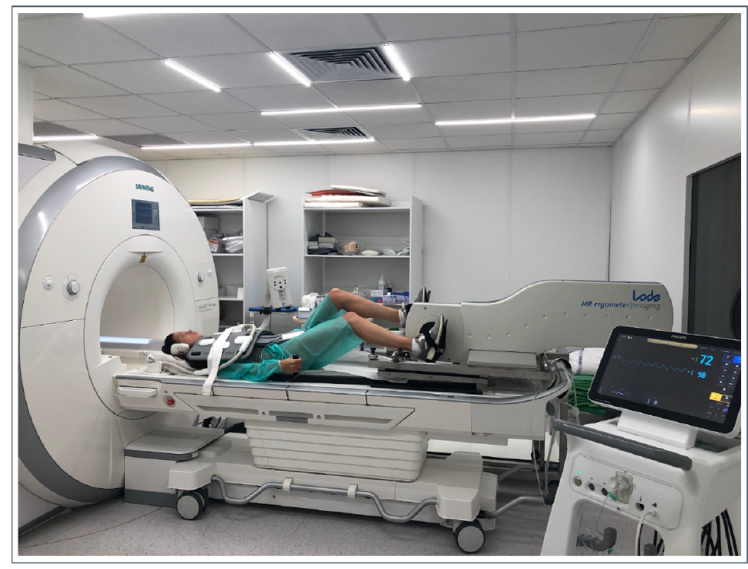
Figure 12. Healthy volunteer is preparing for the stress CMR